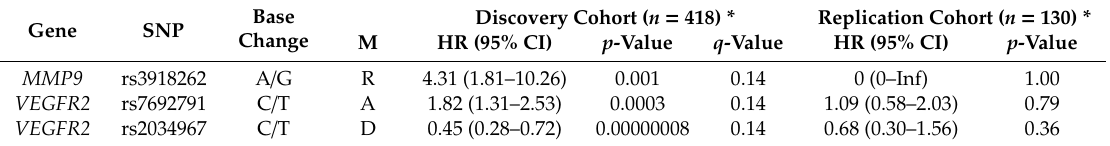
Table 3. Association between SNPs and OS . Hazard ratios (HR) and 95% confidence intervals (95% CI) in the discovery ( n = 418) and replication (130) sets according to gene polymorphisms (SNPs) are listed. Only SNPs that were significant ( p < 0.05 and q < 0.15) in the discovery cohort are reported. Results obtained in the replication cohort are